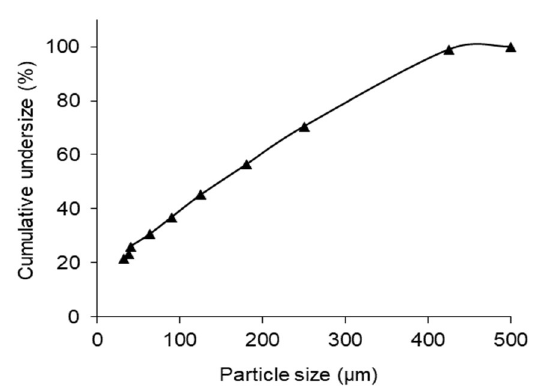
Fig.1 . Cumulative undersize curve of coal